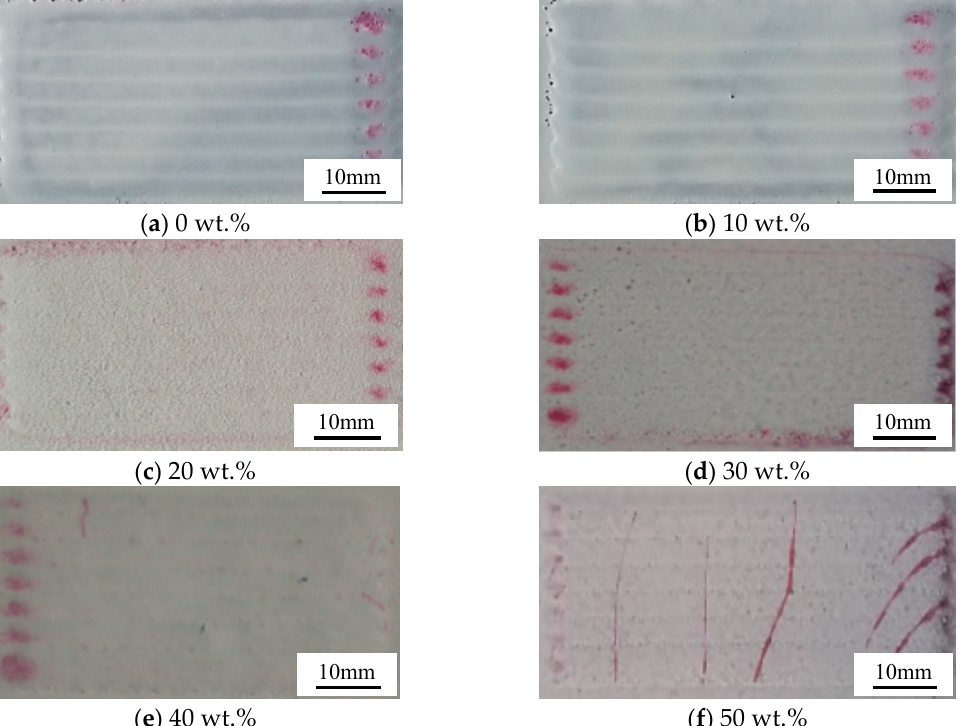
Figure 2. Non-destructive test results of the laser cladded Ni45 + high-carbon ferrochrome